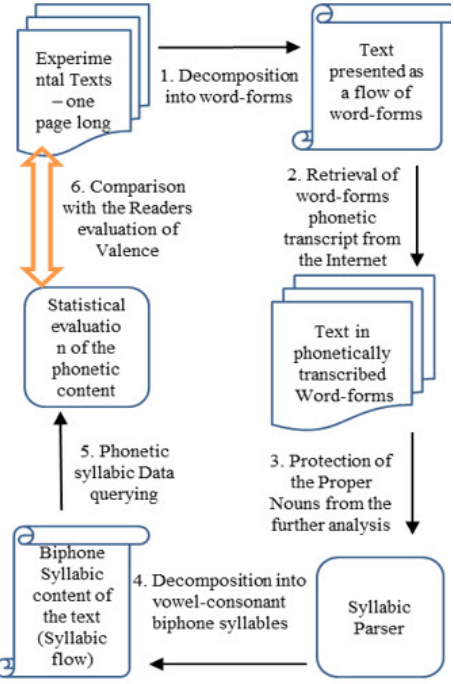
Figure 2. Stages of the